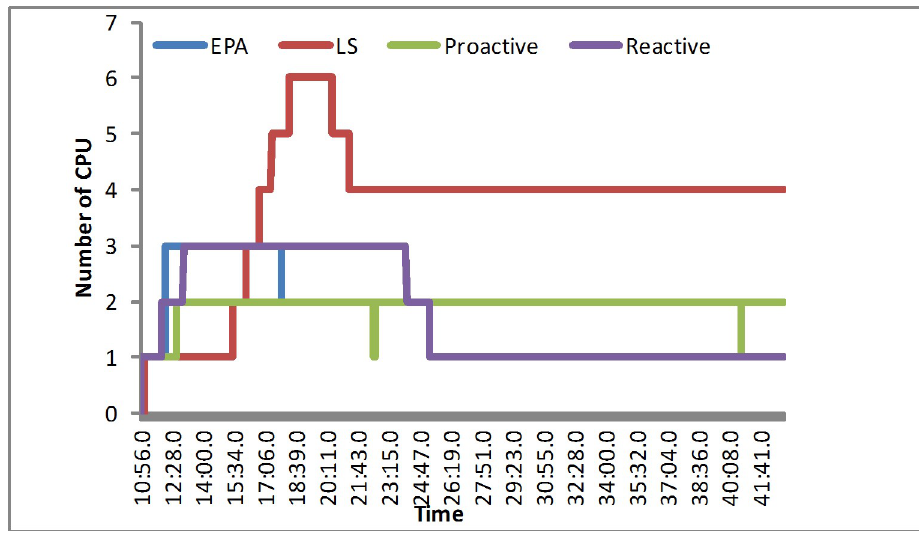
Fig 7. The number of CPUs in the NASA load.